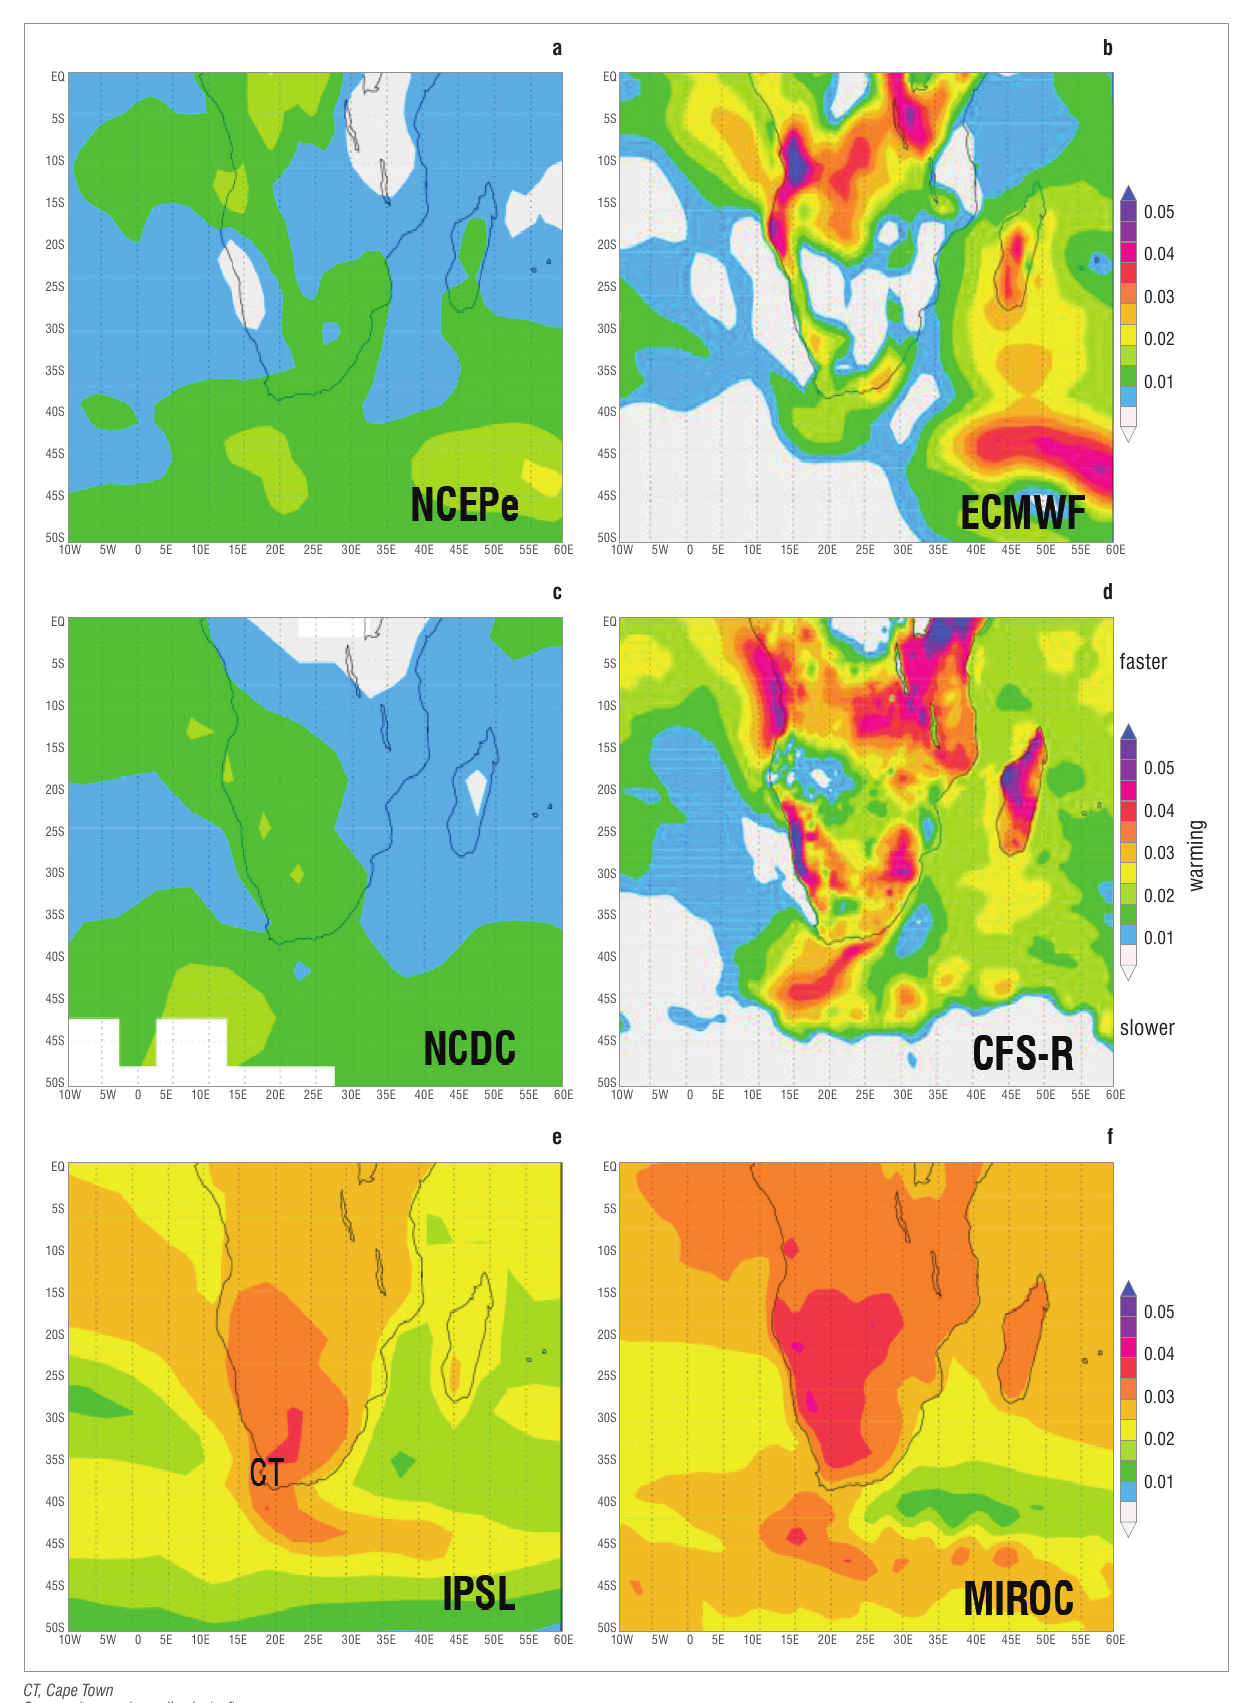
CT, Cape Town Same colour scale applies in (a–f) Figure 2: Surface air temperature trends (°C/year) over southern Africa obtained through linear regression for (a and c) 1900–2010, (b) 1958+, (d) 1979+, and (e and f)